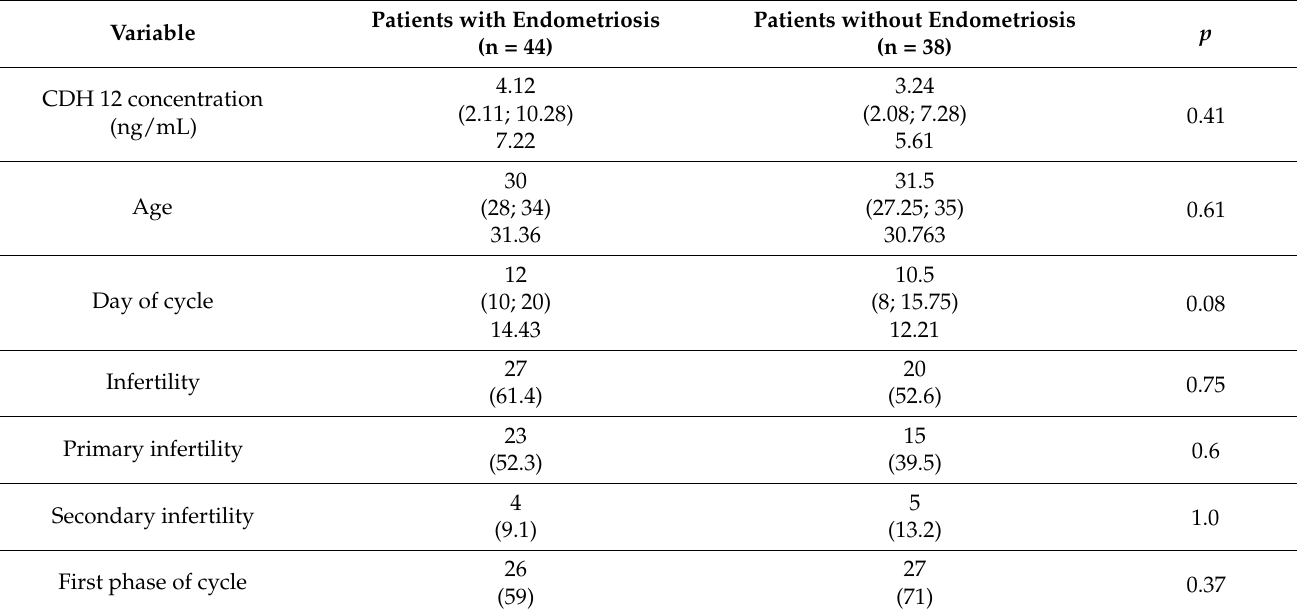
Table 1. Study group (patients with endometriosis) and control group (patients without endometrio- sis)